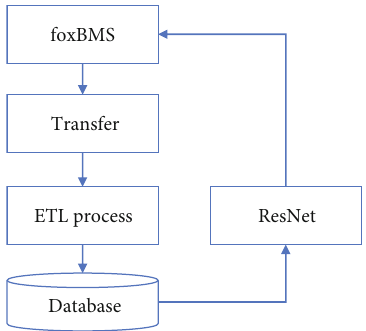
Figure 3: Data pipeline and feedback into